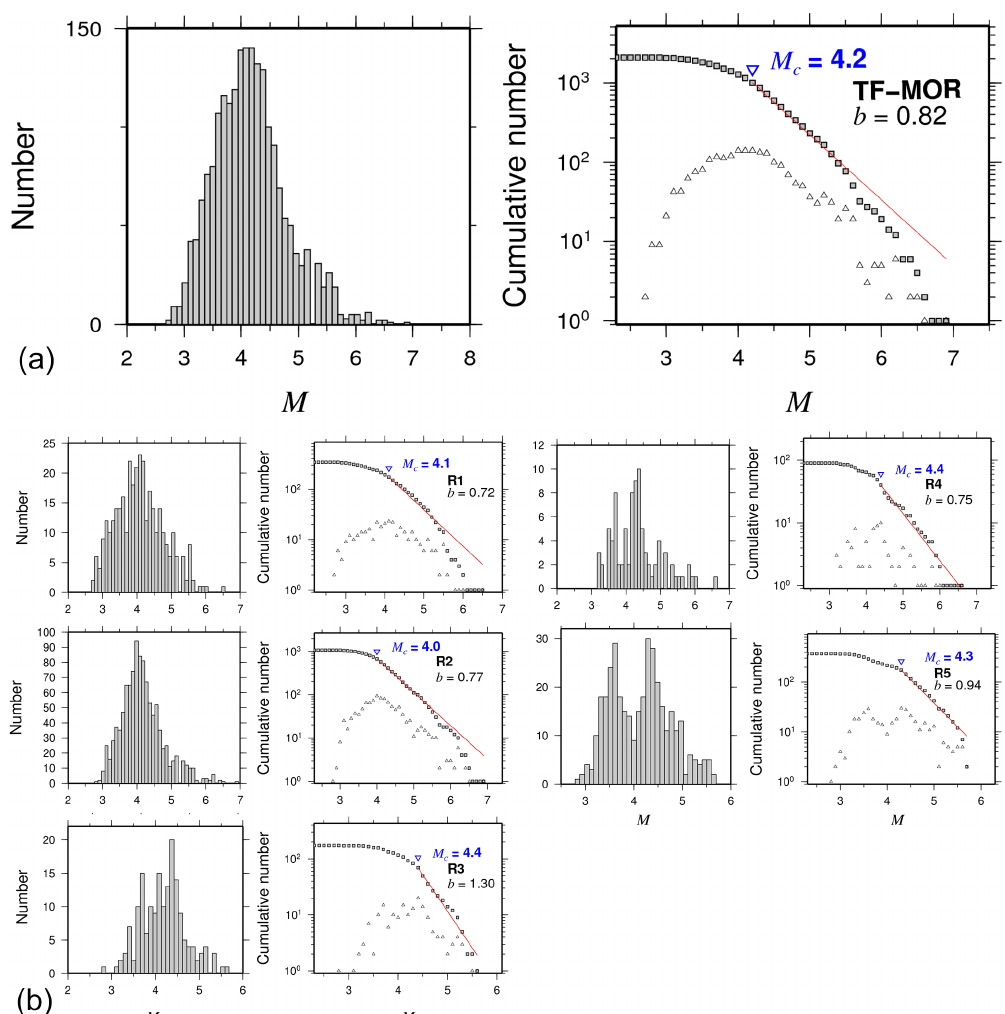
Figure 4. (a) Main statistical characteristics for the transform fault zone and mid-ocean ridge (TF-MOR) events (regions R1 to R5). (b) Mag- nitude earthquake histograms and frequency–magnitude distributions with M c and b values for each of the different subregions shown in Fig. 8.